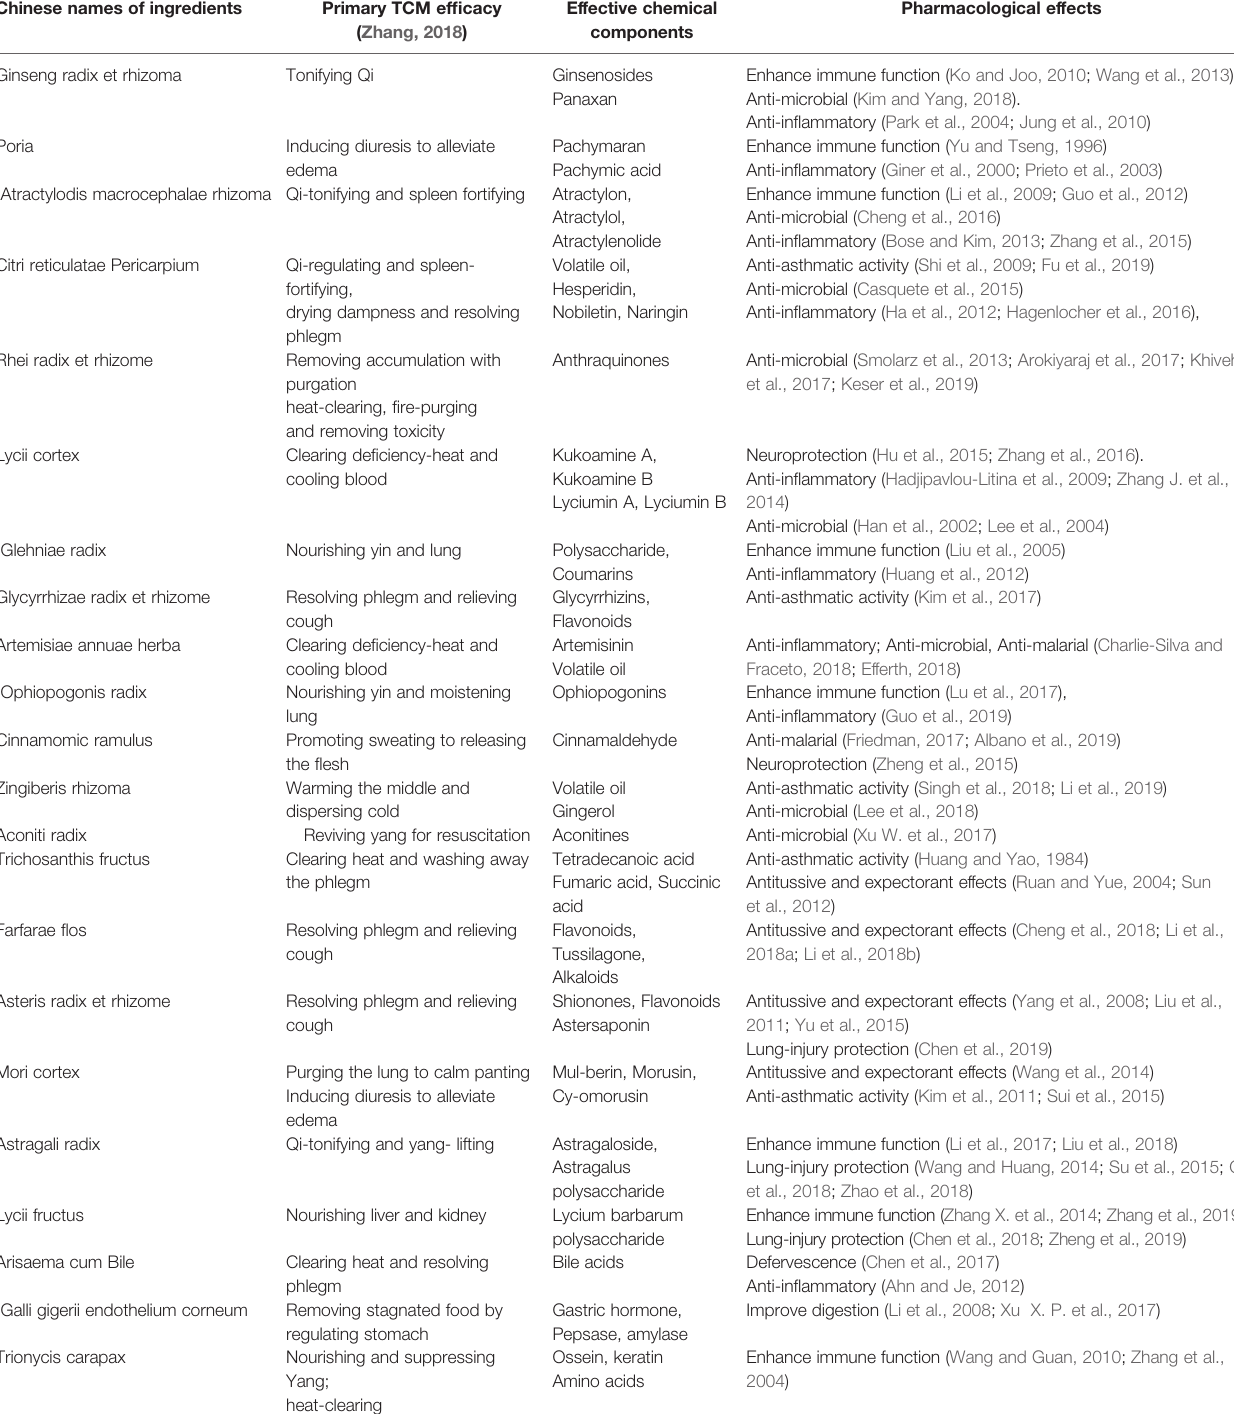
TABLE 3 | Applications of the 22 ingredients of XFG in traditional Chinese medicine. Chinese names of